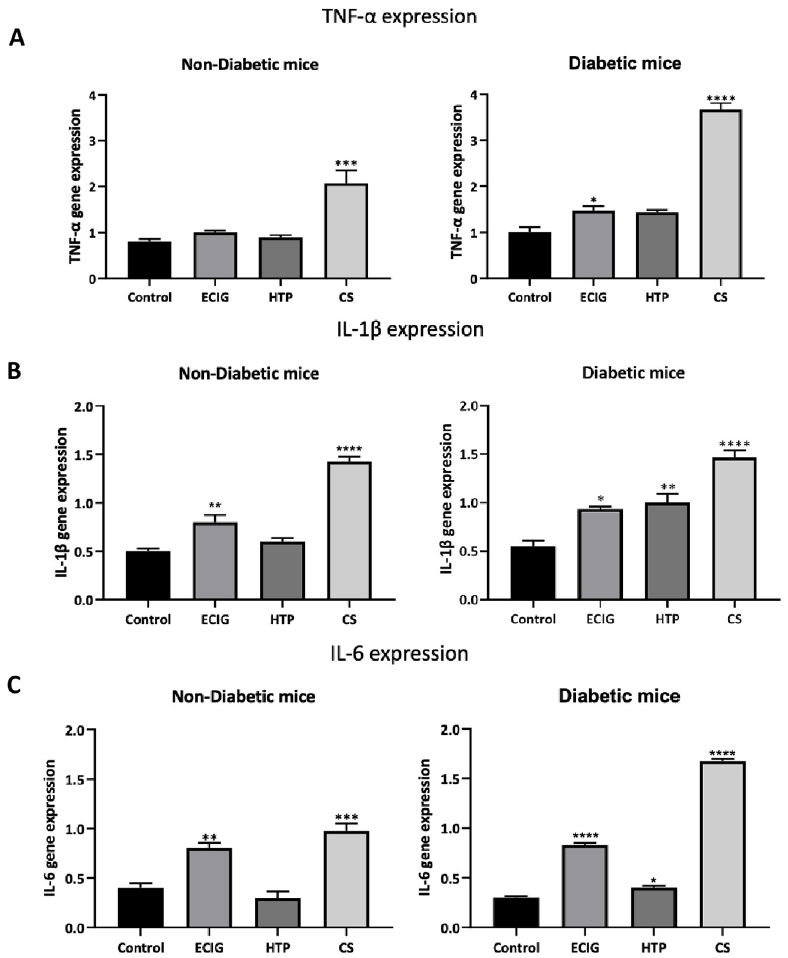
Fig 3. Transcriptional expression of TNF- α (A) IL-1 β (B) and IL-6 (C) of Control, ECIG and CS for Non-Diabetic and Diabetic mice. Expression of inflammatory mediators was assessed by real-time PCR. Error bars represent SE and sterisks indicate statistically significant associations ( � = P-value: < 0.05, �� = P-value: < 0.005, ��� = P-value: < 0.0005, ���� = P-value: < 0.0001).